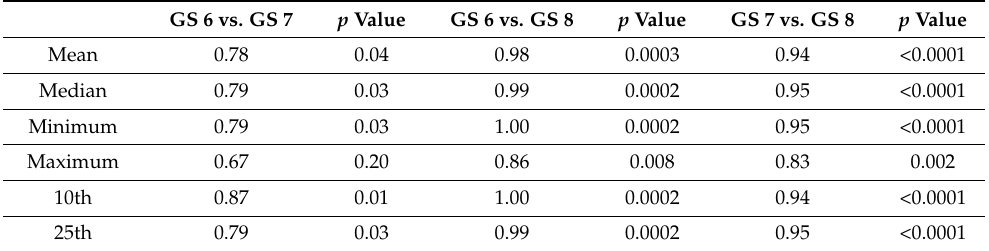
Table 4. Comparison of AUC values used to differentiate tumor foci from prostate cancer.